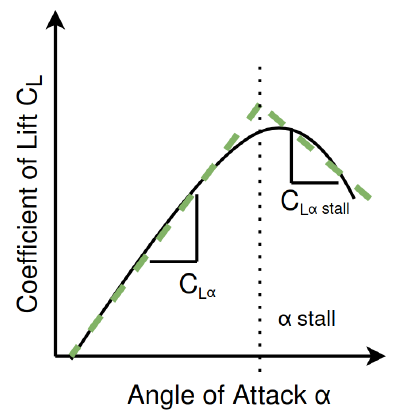
Figure 6. liftdragplugin curve linearization